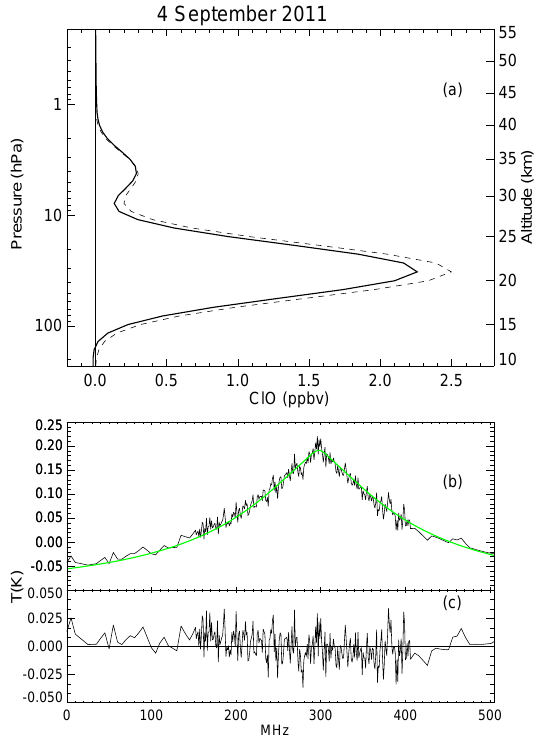
Figure 1. (a) The retrieved day minus night ClO mixing ratio pro- file for 4 September 2011 (solid line), and the a priori profile for that day (dashed line), as a function of pressure (left y axis) and geomet- ric altitude (right y axis). (b) The measured (black line) and mod- eled (green line) spectra. (c) The measured minus modeled residual spectrum.